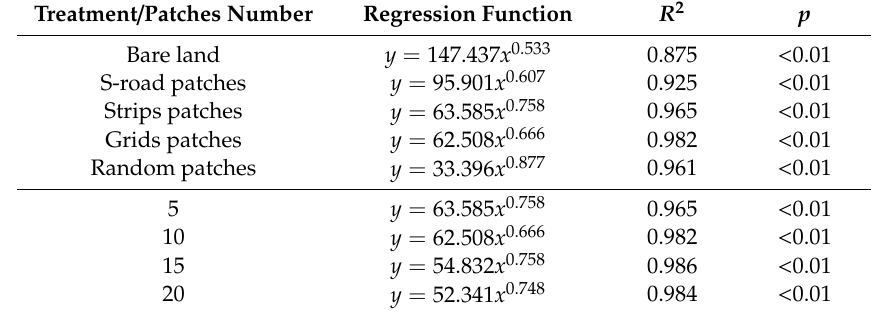
Table 7. Relationships between surface runo ff and soil loss for di ff erent patch types and quantity. Figure 6. Between the rate of runoff ( a ), sediment transport ( b ), and patch area within an experiment.